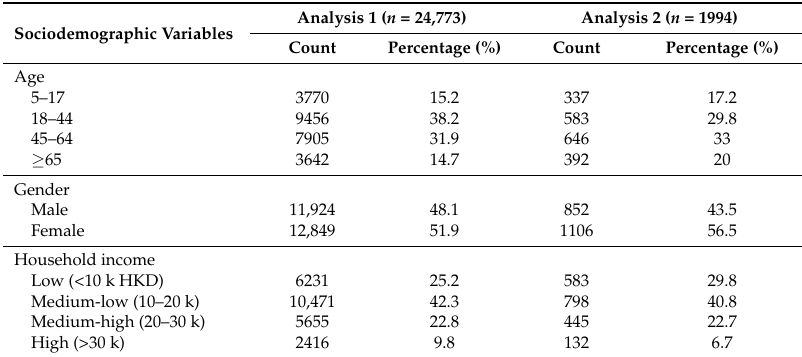
Table 1. Characteristics of study Participants. (Hong Kong SAR, China in 2011. n = 24,773 in Analysis 1, n = 1994 in Analysis 2).